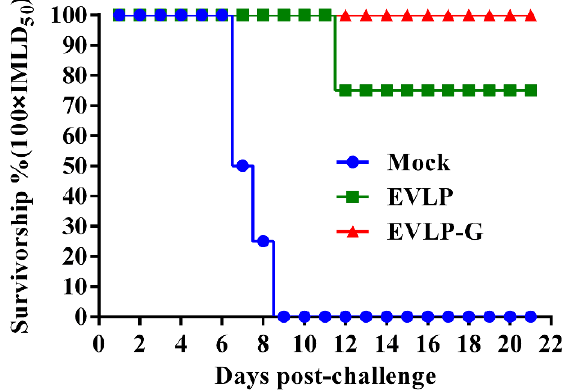
Figure 7. Challenge test in mice. All mice from each group ( n = 8) were challenged with 100 × IMLD 50 of the RABV street stain at 4 weeks after the last vaccination by i.m. route, and the observed for 21 days. The survival of mice in each group at different times after challenge were